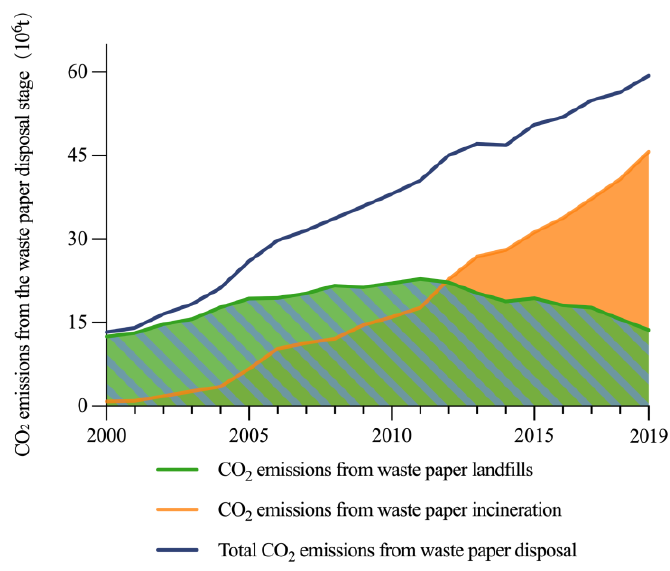
Figure 6. CO 2 emissions from the waste paper disposal of Chinese paper products.